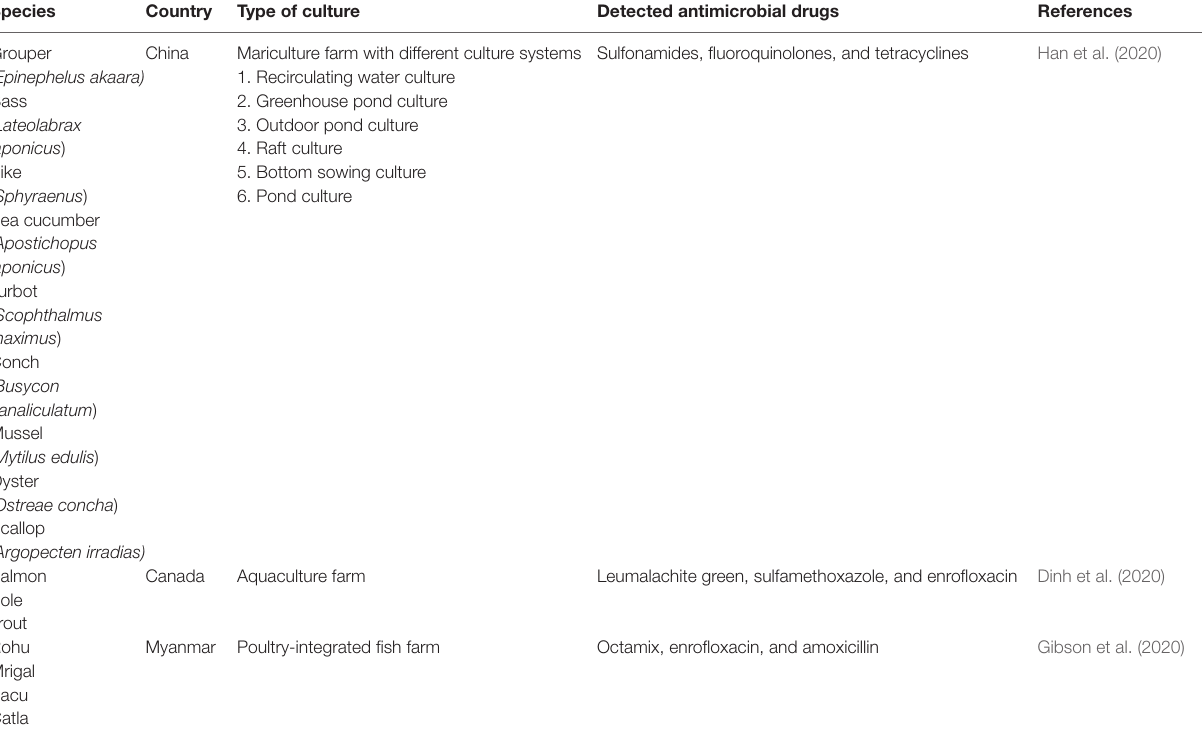
TABLE 3D | Detection of antimicrobial drugs in aquaculture organisms.